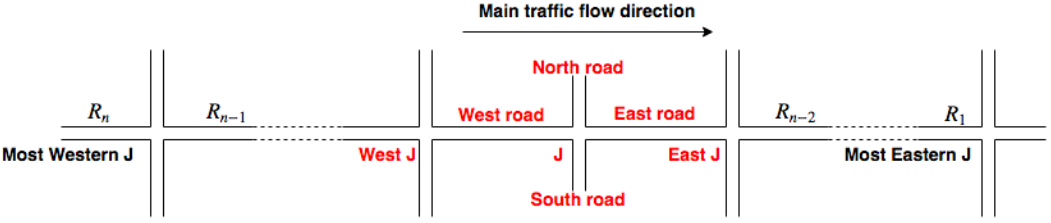
Figure 2. Example of an arterial road with multiple